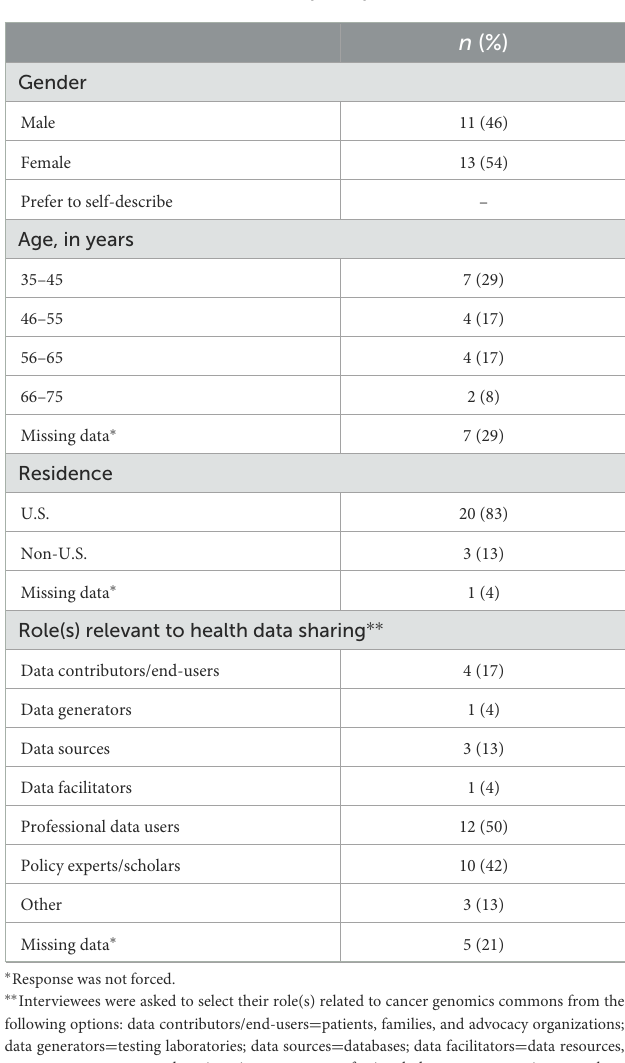
TABLE 1 Characteristics of interview participants ( N =